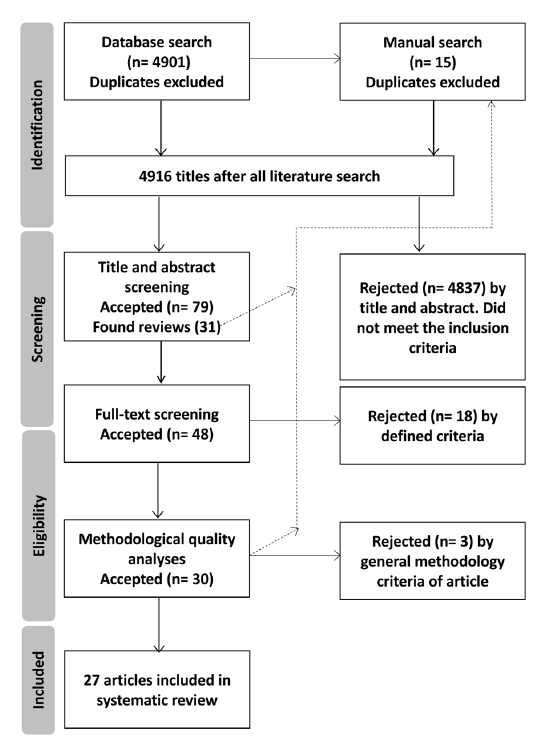
Figure 1. Flowchart of the review for the articles included in the tables. The dotted line demonstrates the stages where a manual search of the reference lists of the selected articles was